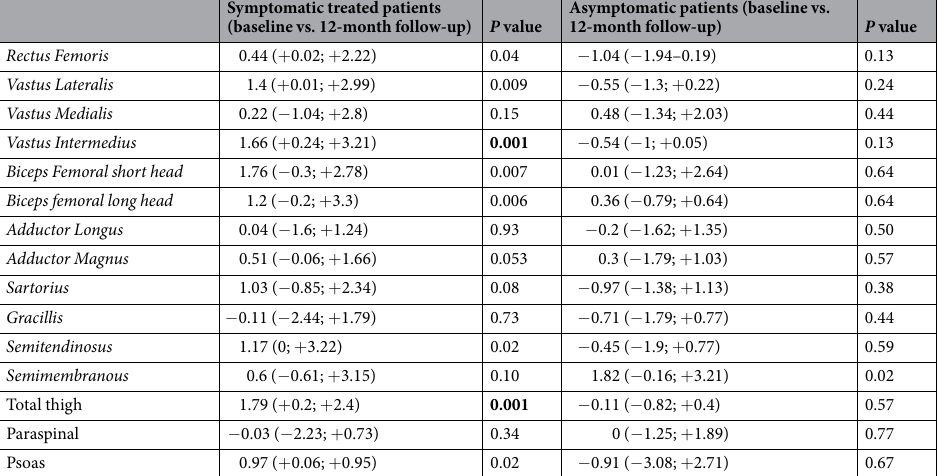
Table 5. Fat fraction progression in every thigh and trunk muscle after one year of follow-up in symptomatic and asymptomatic patients. Median value is shown with 25th–75 th percentiles in brackets. Paired Wilcoxon signed rank test was used to find out whether the differences observed between baseline and year 1 evaluation were statistically significant. Adjustment for multiple comparisons using Bonferroni correction was applied: p was considered significant if lower than 0.004.